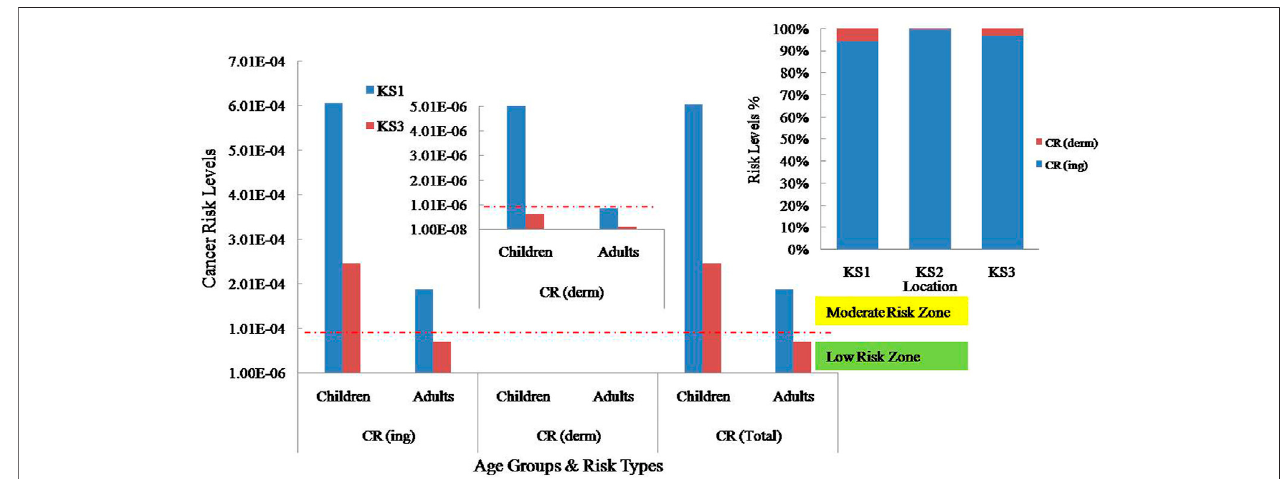
FIGURE 4 | Cancer risk from sediment-bound PAHs at Mohang Harbor (KS1) and the western coastal area (KS3).